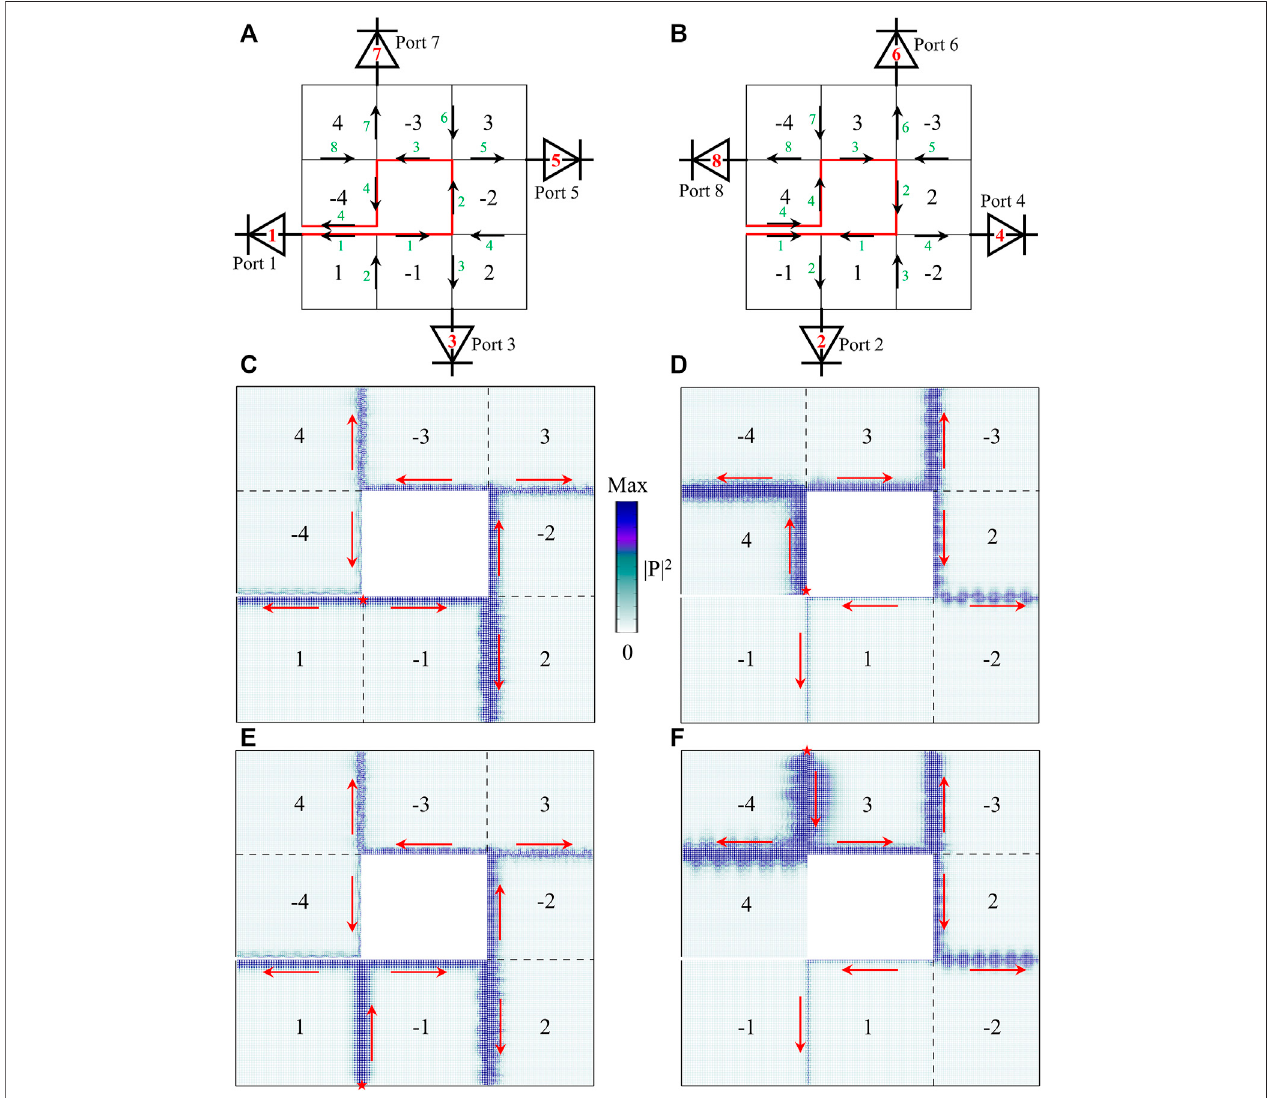
FIGURE 4 | Acoustic diode networks constructed byjoining structures of different C . (A,B) Schematics ofthe acoustic diode networks. Numbers in black indicate theChernnumberforeachSudokusection andthegreennumbers illustratethenumberofedgemodesineach channel.Blackarrowsdepicttheunidirectionalityforthe soundpropagation.Thickredlinesrepresentrigidwallswhiletherestboundariesareimposedbyabsorbingboundaries.Theoutputportsaremarkedbythediodeicons withthe red thick numbers inside them indicating how many modes are outputted from the corresponding port. (C,D) Acoustic intensity fi eld distributions for point source excitations in the diode networks shown in (A,B) . The source locations are marked by red stars and the excitation frequency is chosen as 996.25 Hz (E,F) The same as (C,D) , only that the excitations are launched by two outside-coming signals (indicated by red stars).